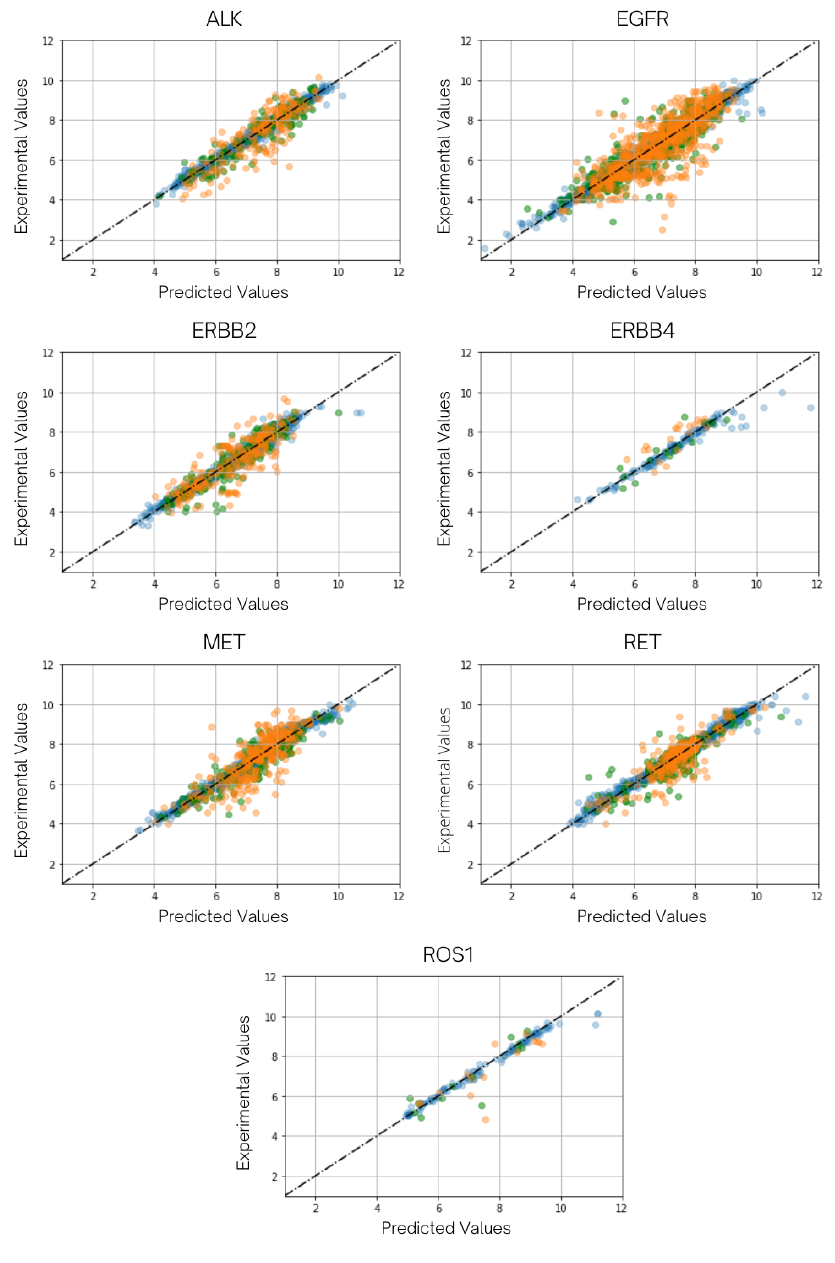
Figure 4. The plots display the distribution of model-predicted values versus experimental values of the seven tyrosine kinases with ideal dashed trendlines (y = x). The training set, validation (internal test) set, and external test set are represented by light blue, green, and amber marks,